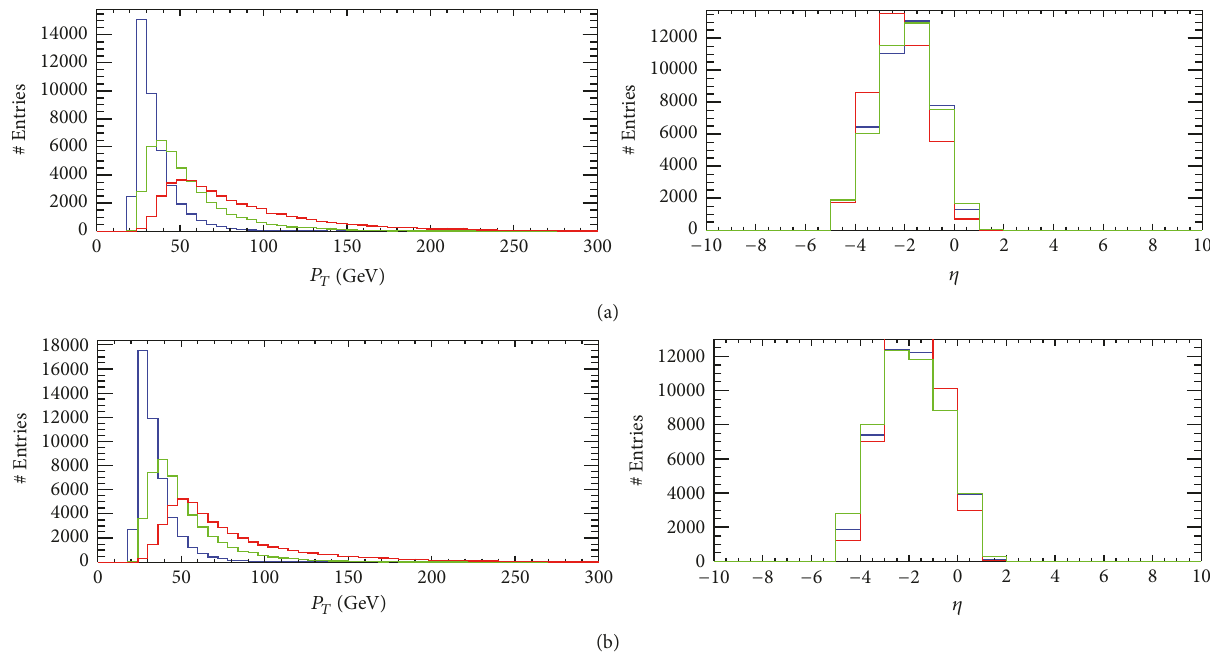
Figure 4: Transverse momentum and pseudo-rapidity distributions of three jets from the process 𝑒 − 𝑝 → 𝑒 − 𝑊 ± 𝑞 + 𝑋 for background ( 𝐵1 ) (a) and the process 𝑒 − 𝑝 → 𝑒 − 𝑍𝑞 + 𝑋 for background ( 𝐵2 ) (b) at the LHeC.